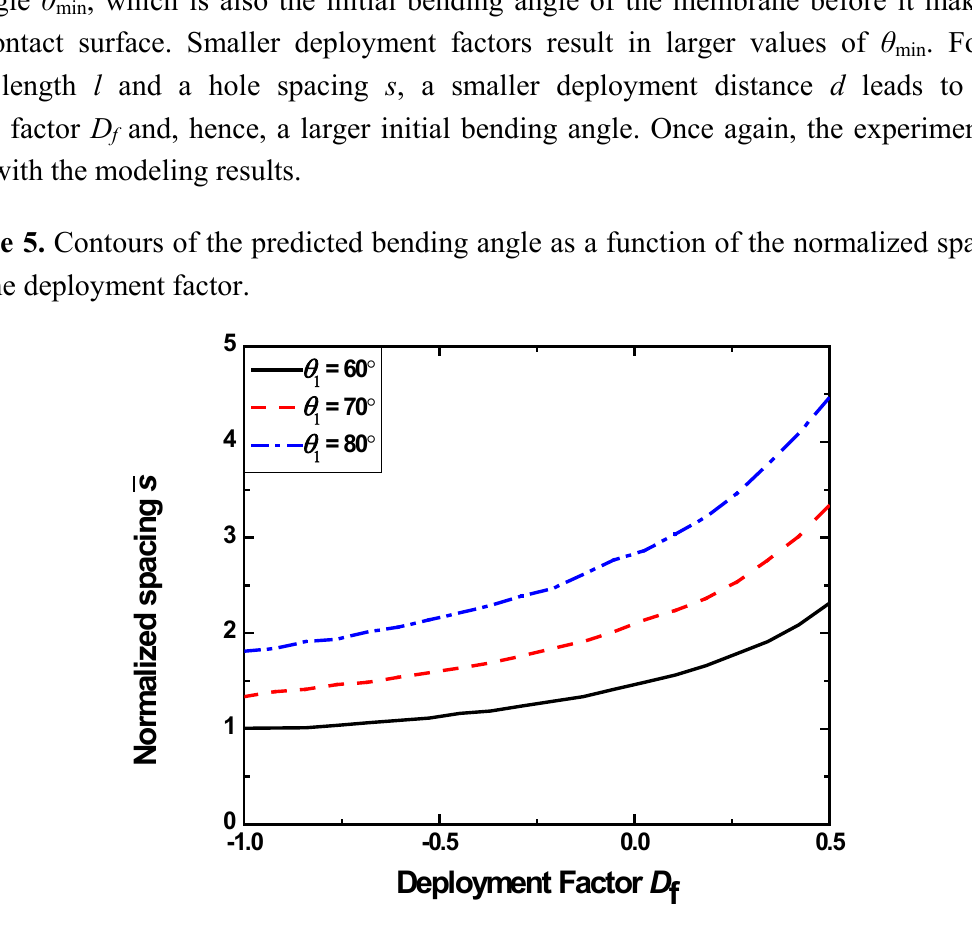
Figure 6. Optical images of the membranes of different thicknesses in contact with a featureless flat surface for different deployment